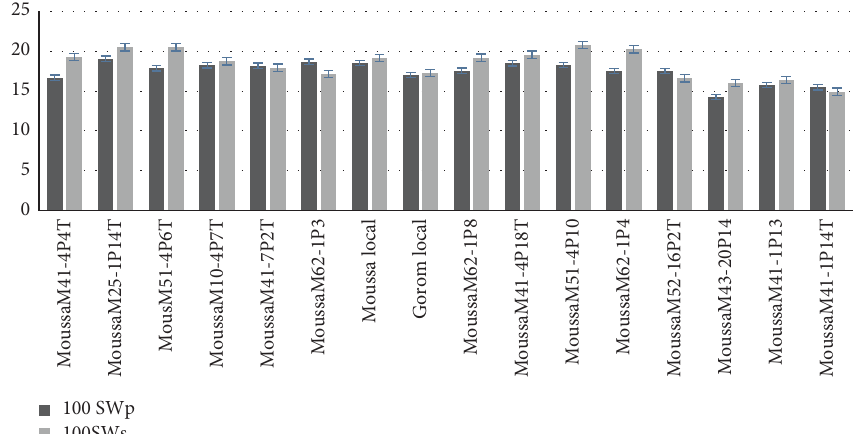
Figure 5: Hundred seed weight of mutant and controls under nonstressed and stressed conditions. SWp: seed weight in nonstressed conditions; SWs: seed weight in stressed